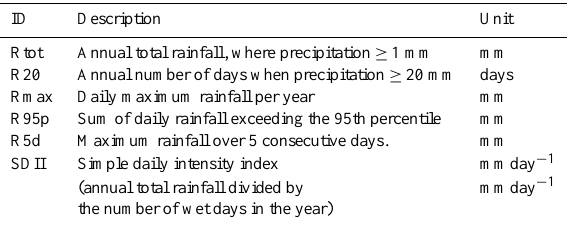
Table 2. Description of the rainfall indices used. ID Description Unit Rtot Annual total rainfall, where precipitation ≥ 1 mm mm